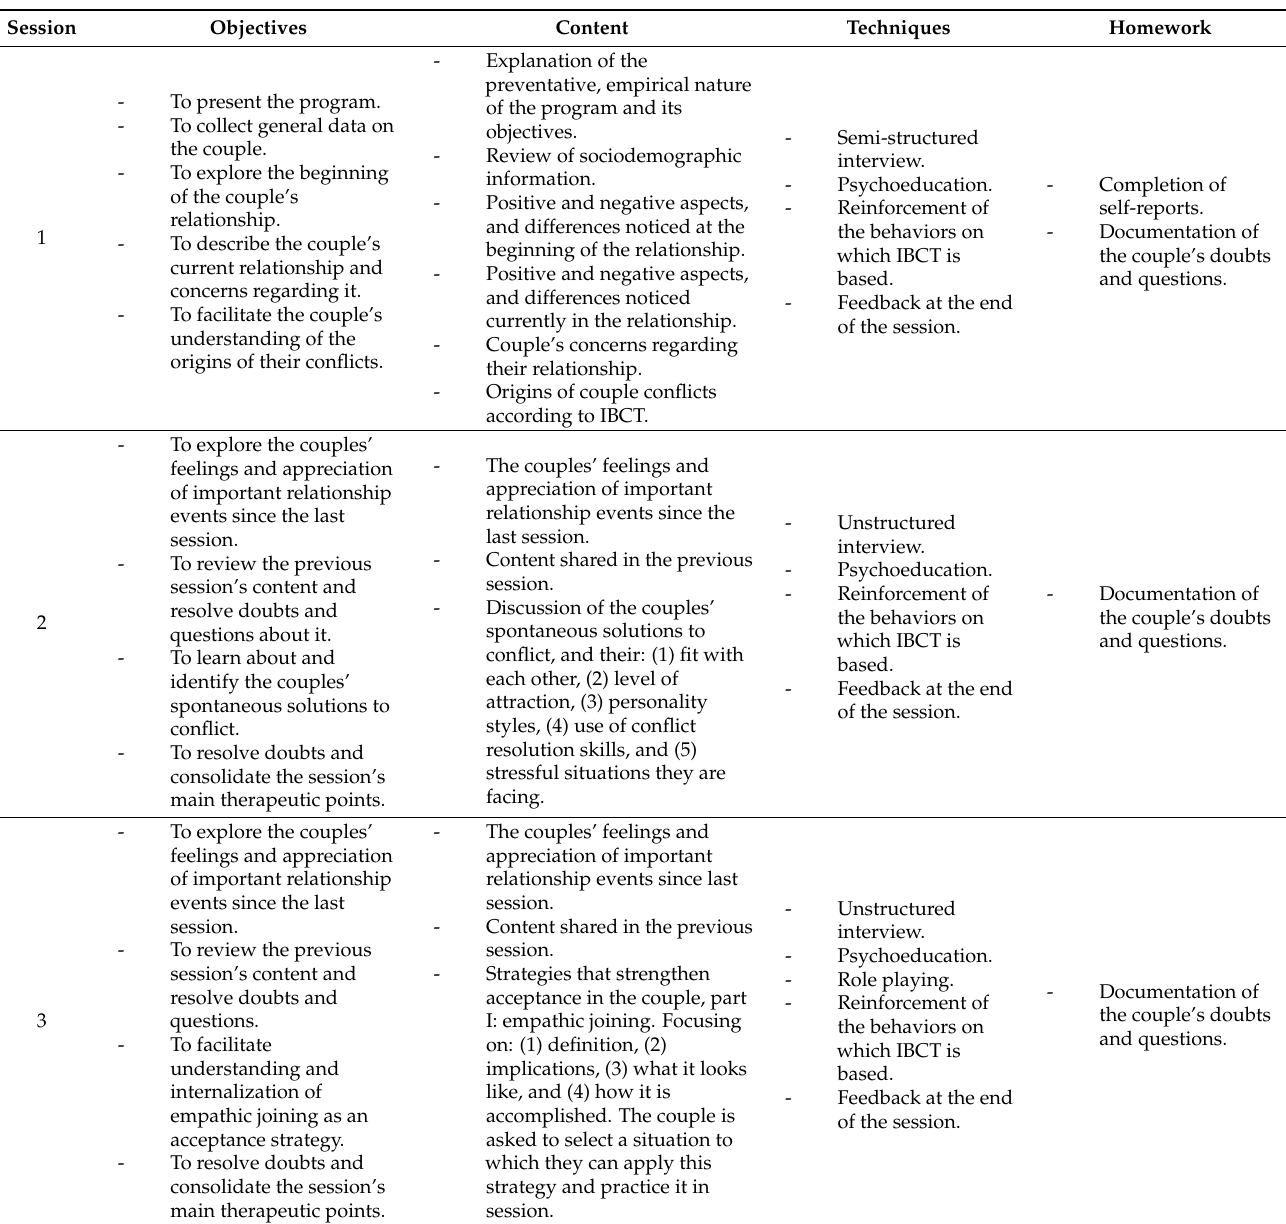
Table 2. Sessions, objectives, content, techniques, and homework for the IBCT-based conflict prevention program.